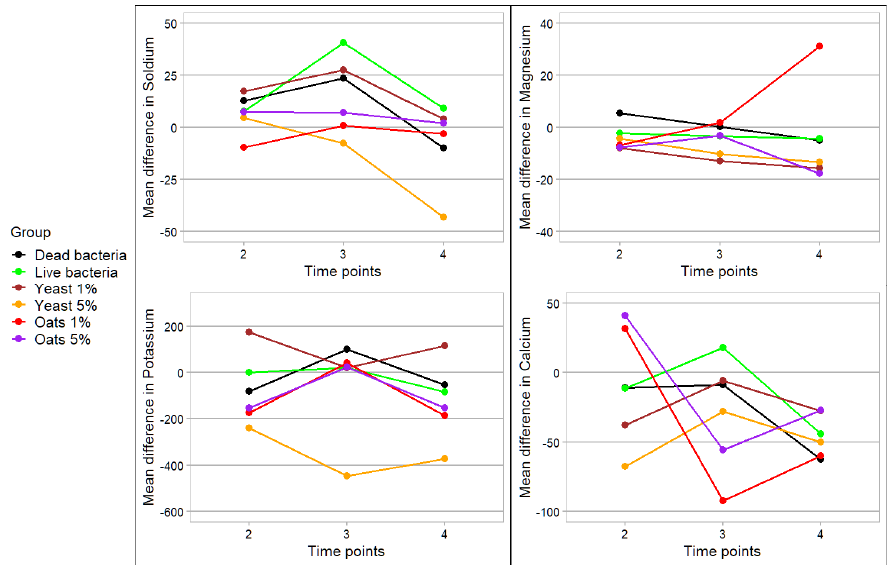
Figure 1. Mean differences in minerals per time point from baseline values.